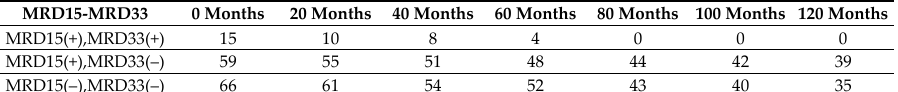
Figure 5. Outcomes of the patients (n-140), 5y RFS, by response to MRD (negative, <0.01% vs. positive, ≥ 0.01%) on days 15 (TP1) and 33 (TP2).